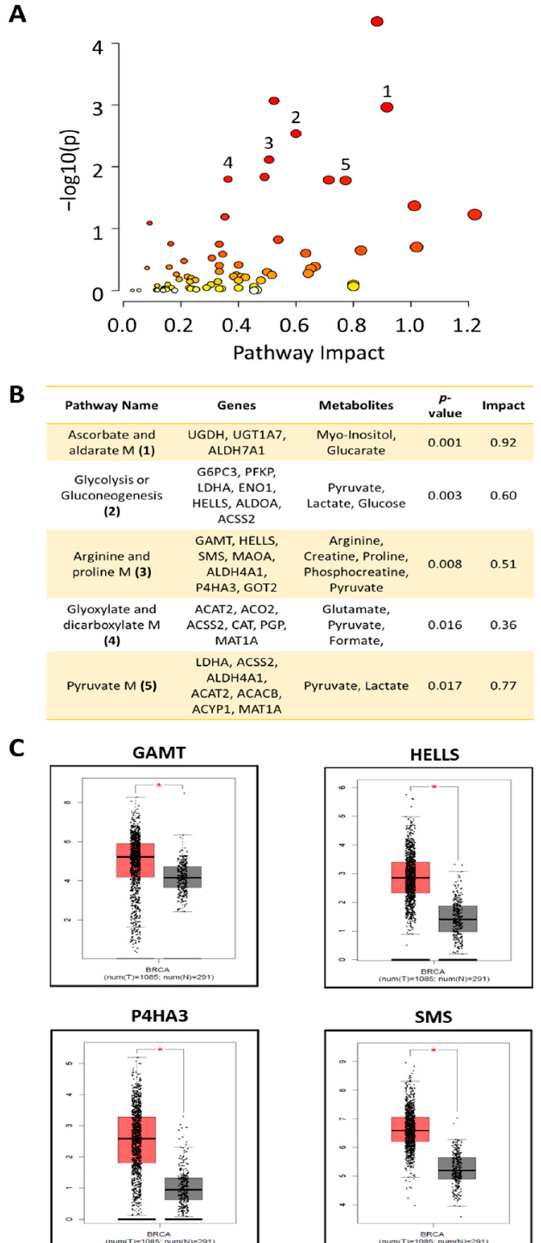
Figure 7. Joint-Pathway Analysis using MetaboAnalyst. ( A ) Overview of the matched pathways according to the p -values resulted from joint-pathway analysis of the upregulated DEGs and quantified metabolites. Dots illustrate all the pathways that were found enriched represented by upregulated DEGs and/or quantified metabolites. ( B ) The statistically significant enriched pathways ( p < 0.05) represented by both upregulated DEGs and metabolites. Numbers indicated the respective dots in ( A ). Upregulated DEGs and quantified metabolites matching with each pathway are presented. ( C ) Genes associated with the “Arginine and proline M” and found statistically significant different between breast cancer tumors and normal samples in GEPIA database. M; metabolism/metabolites, G; genes. *: p <